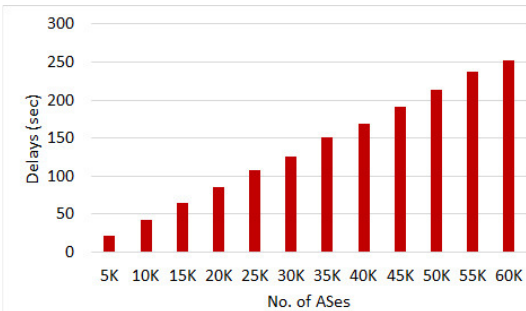
Figure 13. Payload Dissemination Delays with varying AS Count.